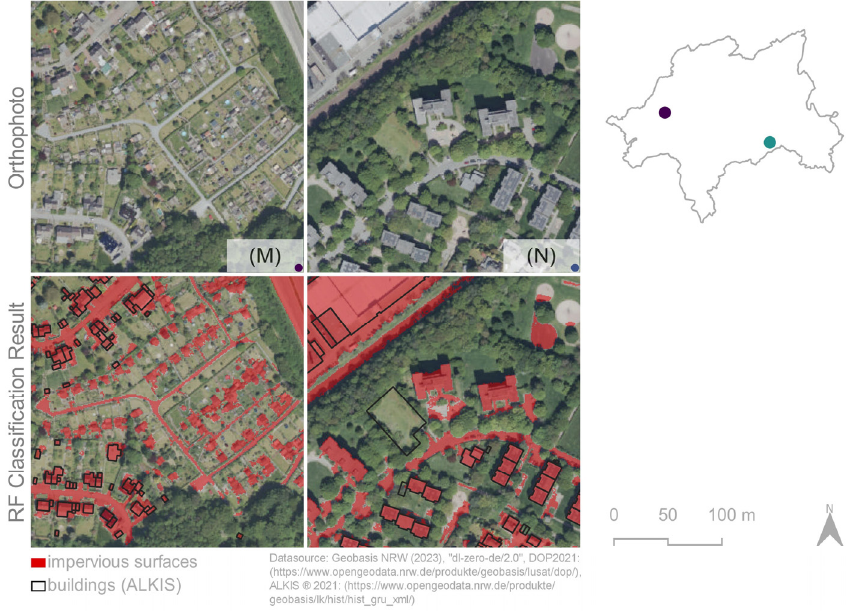
Figure 14. Visualisation of data gaps present in the ALKIS land use dataset.